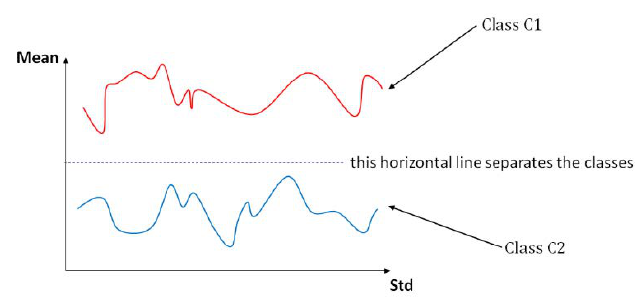
Figure 1. The two classes are separated by a horizontal line.